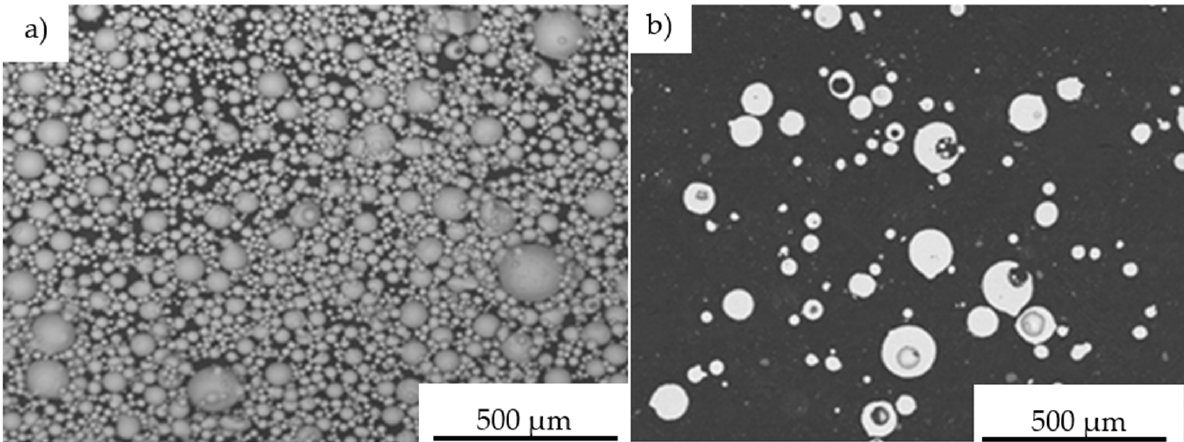
Figure 10. Morphology of Fe40Al at.% powder particles used in D-gun spraying into water: the dimension heterogeneity of the spherically structured particles ( a ), the cross-section reflecting the porosity of FeAl particles in their volume ( b ).